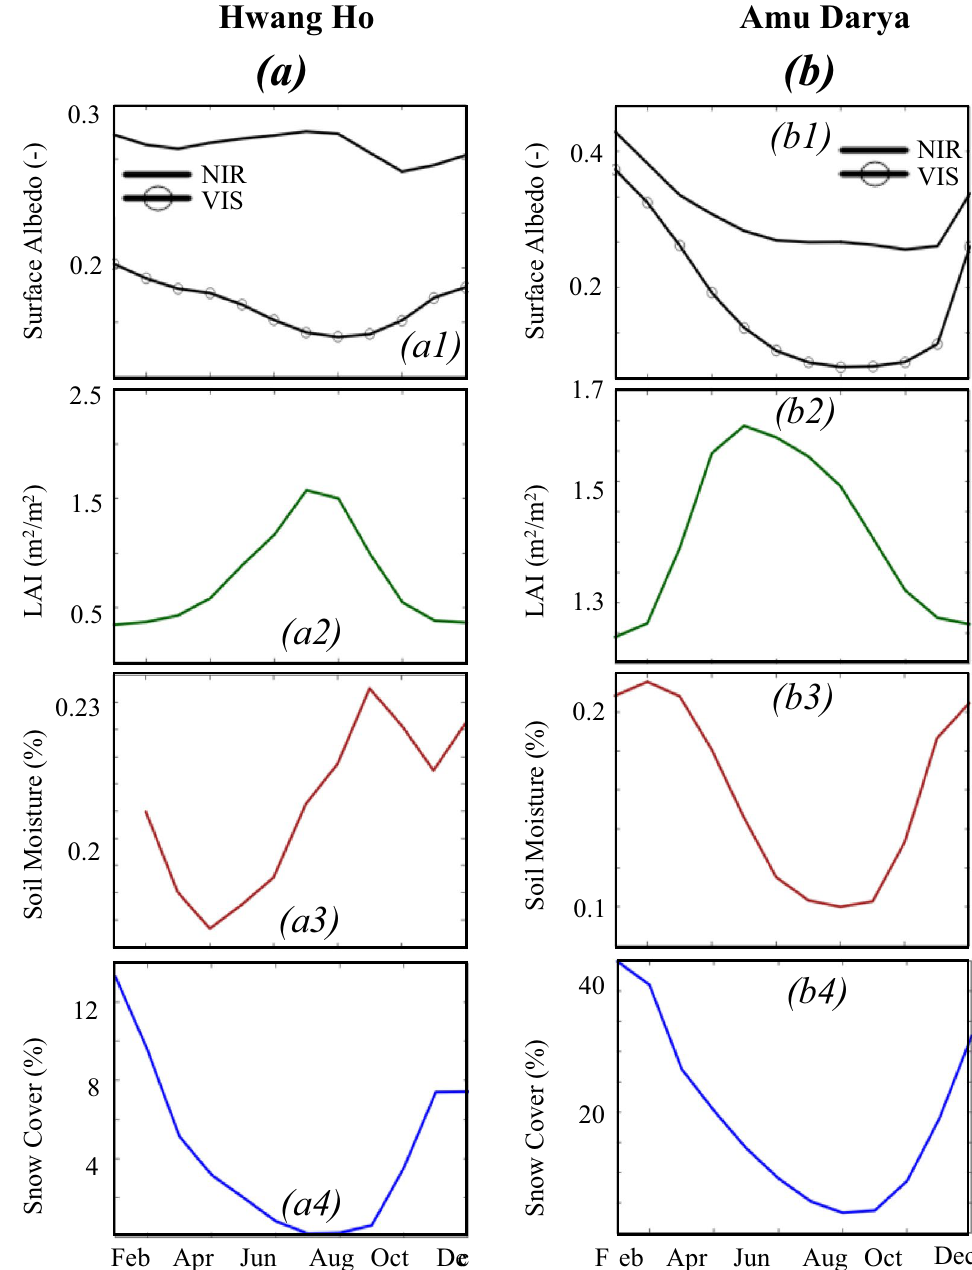
Figure 5. Monthly variations of the averages of surface albedo, LAI, soil moisture and snow cover in basins where surface albedo changes are controlled by greening, soil moisture, and snow cover ( a ) Hwang Ho, and ( b ) Amu